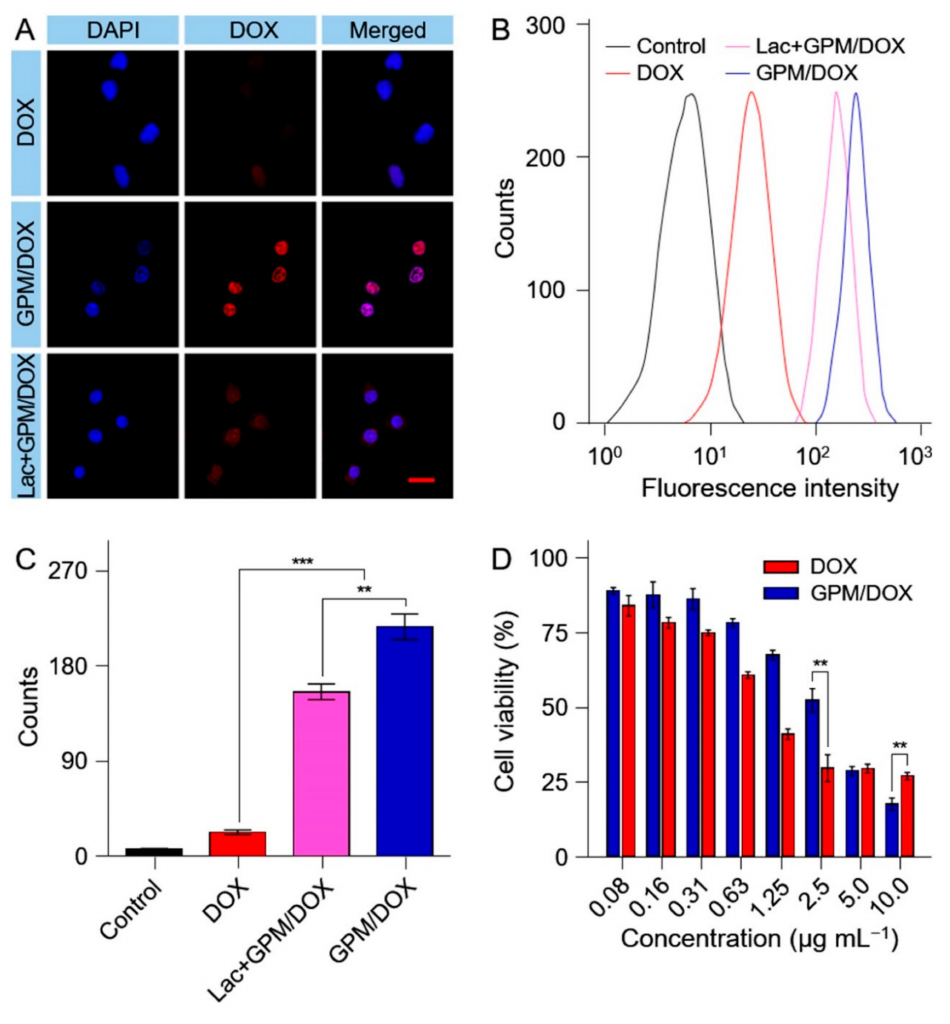
Figure 2. Cellular uptakes and intracellular DOX release of GPM/DOX and free DOX after incubation with HepG2 cells for 2 h detected by ( A ) Confocal laser scanning microscopy (CLSM) and ( B ) Flow cytometry method (FCW) analyses; ( C ) The quantization of FCM; ( D ) In vitro cytotoxicities of GPM/DOX and free DOX after incubation with HepG2 cells for 24 h; data were presented as a mean ± SD ( n = 5; ** p < 0.01, *** p < 0.001); scale bar = 50 µ